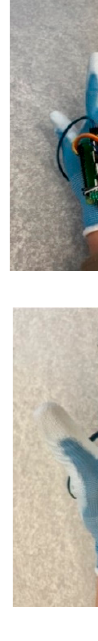
Figure 15. Subject wearing devices.